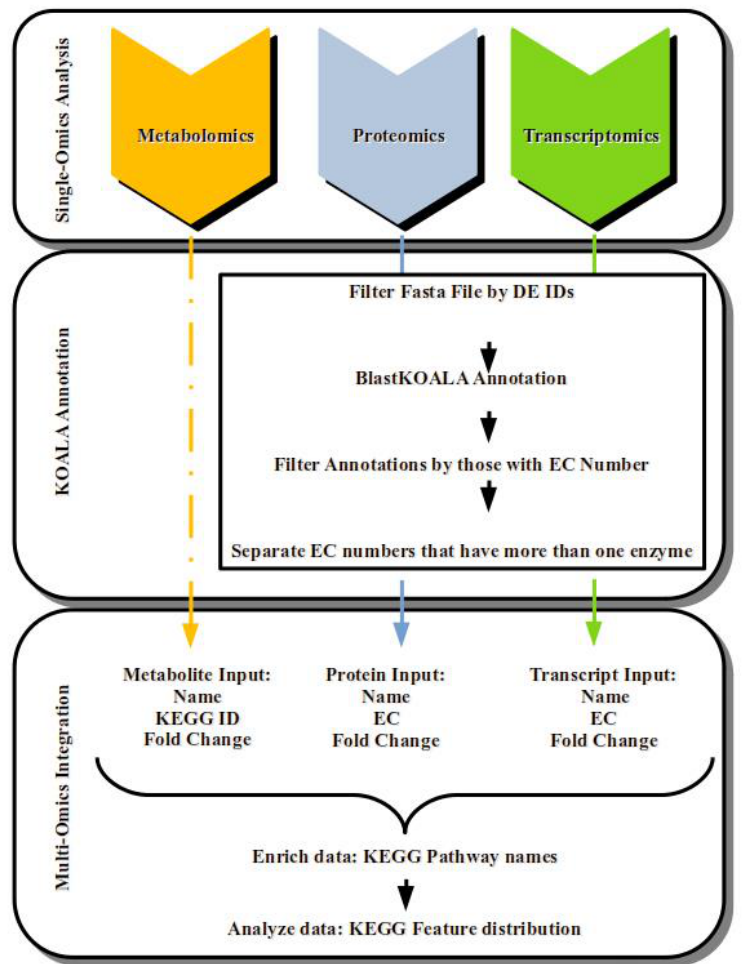
Figure 3. Summarized workflow used to Single-Omics Analysis (SOA), KOALA Annotation, and Multi-Omics Integration (MOI) applied to characterize the transcriptomics, proteomics, and metabolomics datasets generated from the leaves of young oil palm plants submitted to abiotic